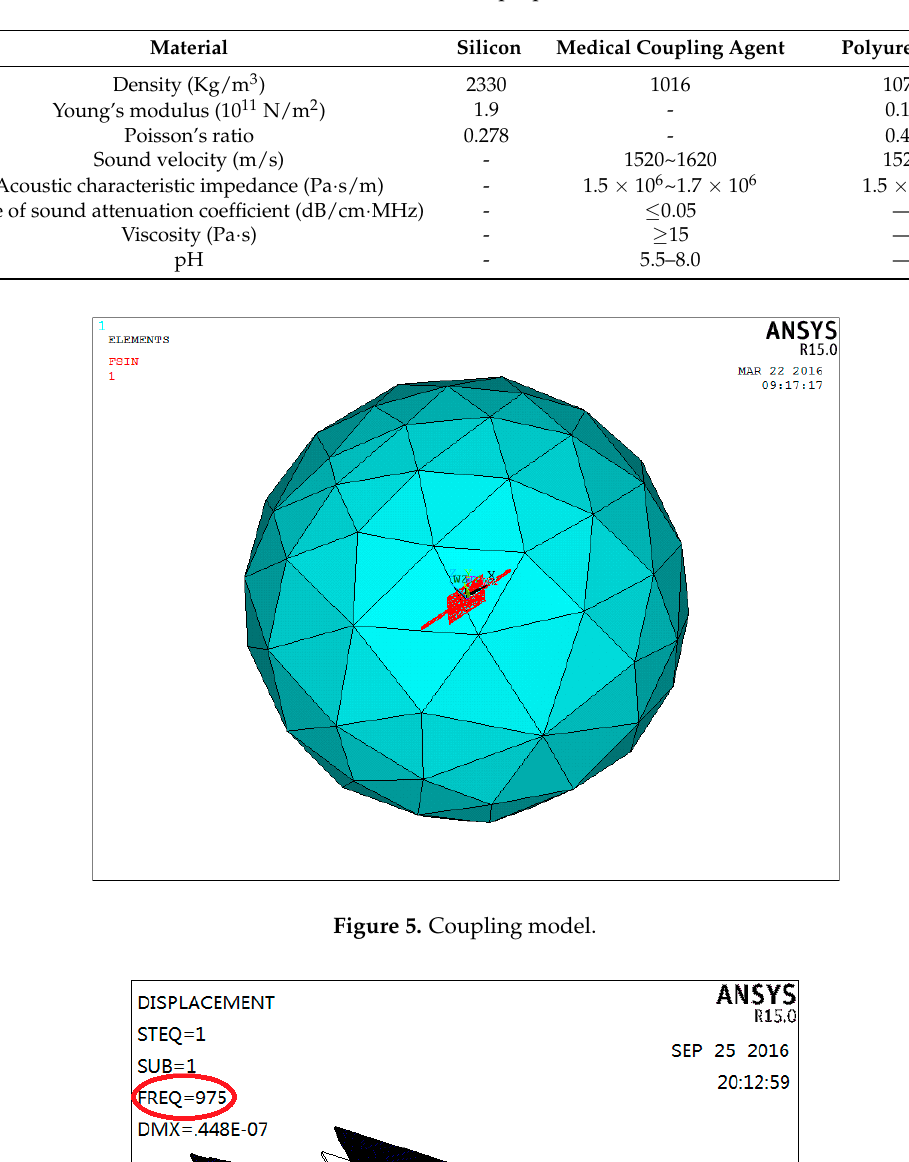
Figure 6. From Figure 6 it can be obtained that the resonant frequency of the microstructure is 975 Hz. The clinically-valuable heart sound frequency range is often concentrated in the range 20~600 Hz, so the microstructure can meet the requirements of the application.